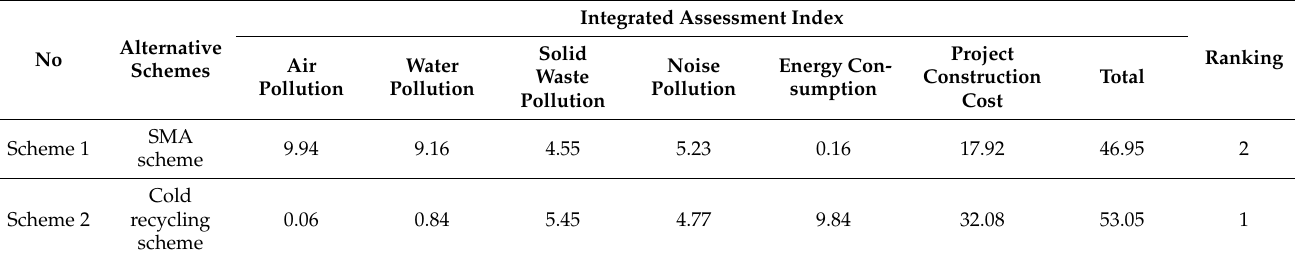
Table 4. Integrated assessment index ranking.